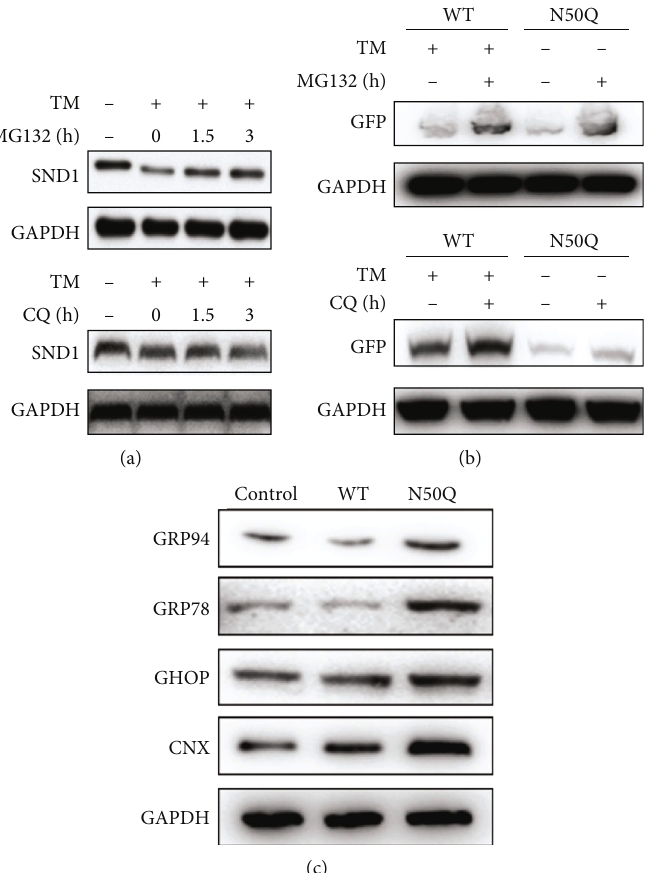
Figure 4: N-glycosylation of Asn50 induces ER-associated degradation of SND1. (a) U87 cells overexpressing wild-type SND1-EGFP were pretreated with 1 μ g/mL TM for 24 h, followed by culture with 10 μ M MG132 or 50 μ M CQ for 0 h, 1.5 h, and 3 h. The expression level of exogenous SND1 was then determined by immunoblot. (b) U87 cells overexpressing wild-type SND1-EGFP and N50Q-EGFP were treated with MG132 for 3h before collection of whole lysates. Exogenous expression was then determined by immunoblot. (c) Cells expressing EGFP, SND1-EGFP, and N50Q-EGFP were analyzed by western blot to determine the levels of GRP94, GRP78, CHOP, and CNX. GAPDH was used as a loading control. All these data are representative of at least three independent